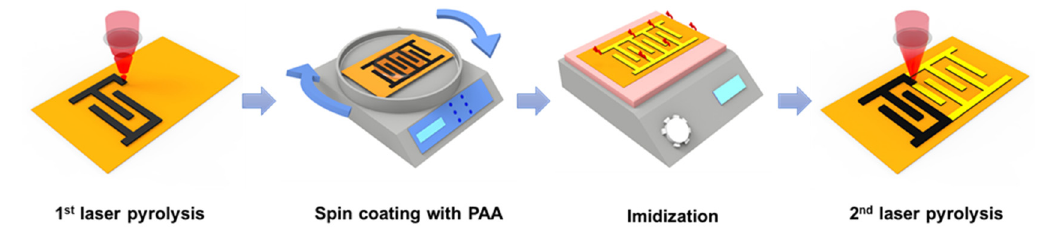
Figure 2. The fabrication process for the d-LIG-MSC electrodes.